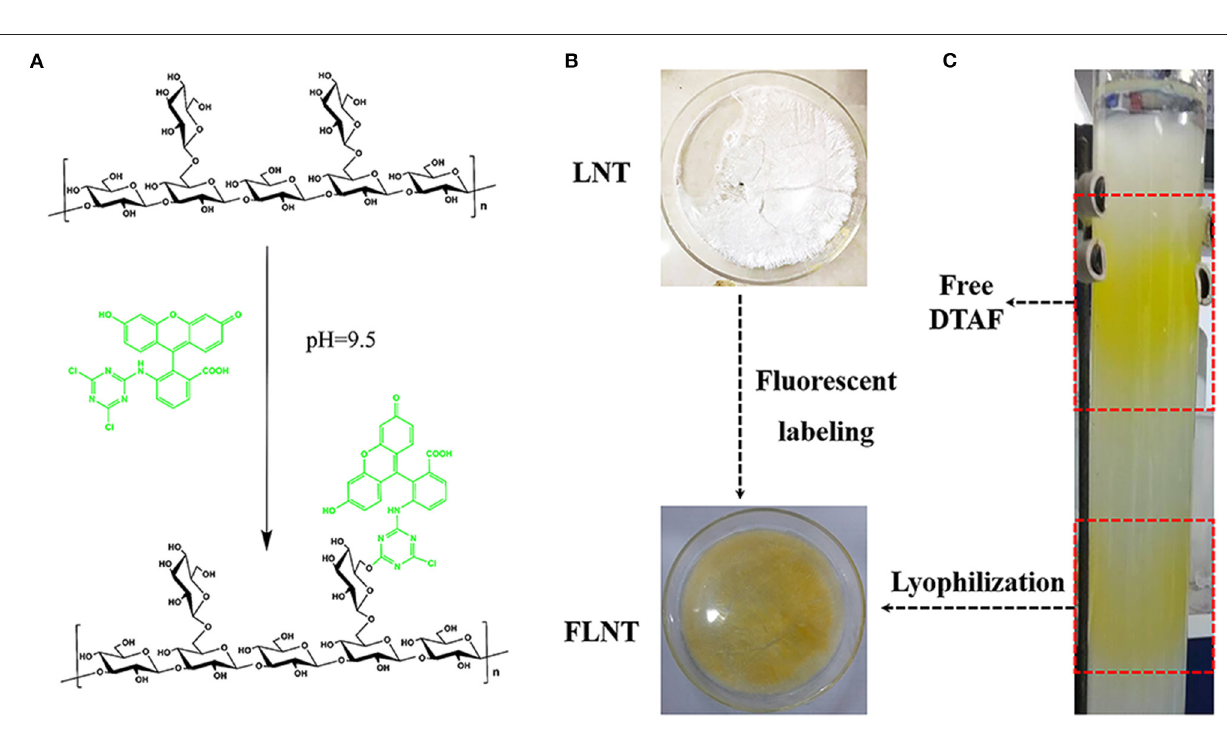
Frontiers in Veterinary Science | www.frontiersin.org 3 June 2022 | Volume 9 | Article